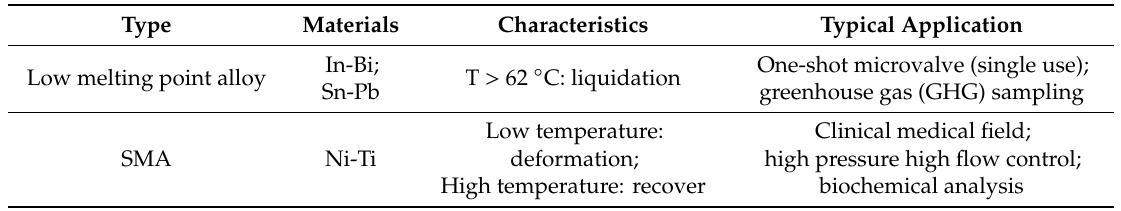
Table 8. Comparison of di ff erent metal materials applied to